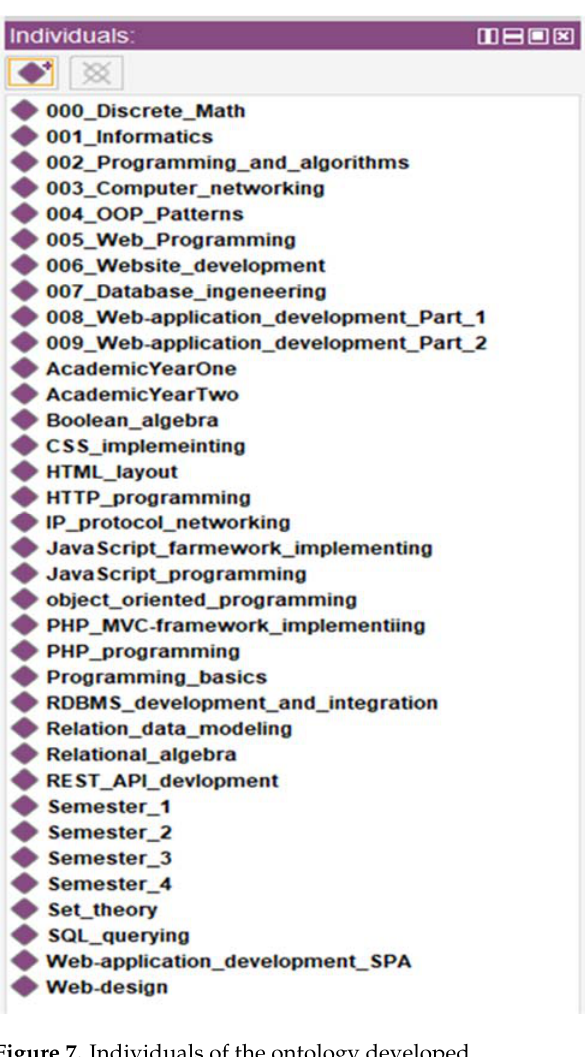
Figure 7. Individuals of the ontology developed.